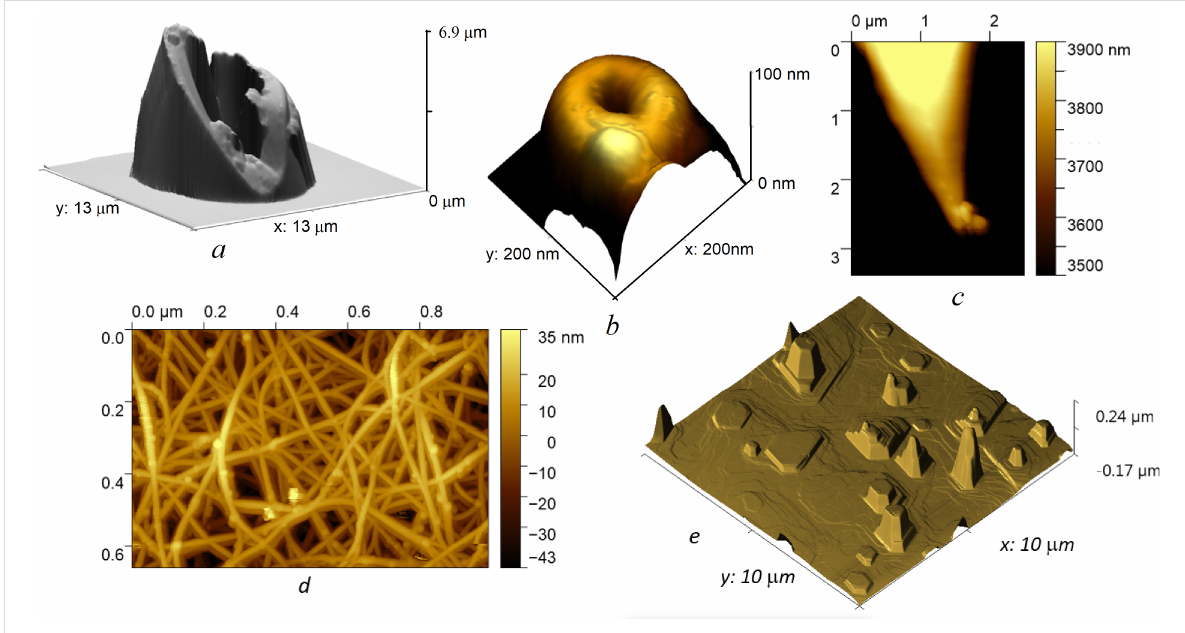
Figure 2: Vertical mode imaging. AFM images of the top of a broken micropipette (a) and an intact micropipette (b); AFM image of the tip of the probe (c), the surface of a SWCNT film (d); AFM image (without processing) of the surface of bismuth telluride (e). Scanning parameters for (a): 256 by 256 points, A 0 = 12 nm, T line = 2 s, T dir =1.8 s, V up = 20 µm/s, V down =10 µm/s, p 1 = 70%, p 2 = p 1 + 4%, f r = 245 kHz, T scan = 16 min. Scanning parame- ters for (d): 512 by 314 points, A 0 = 12 nm, T line = 1 s, T dir = 0.8 s, V up = 5 µm/s, V down =2 µm/s, p 1 = 70%, p 2 = p 1 + 8%, f r = 233 kHz, T scan = 21 min.